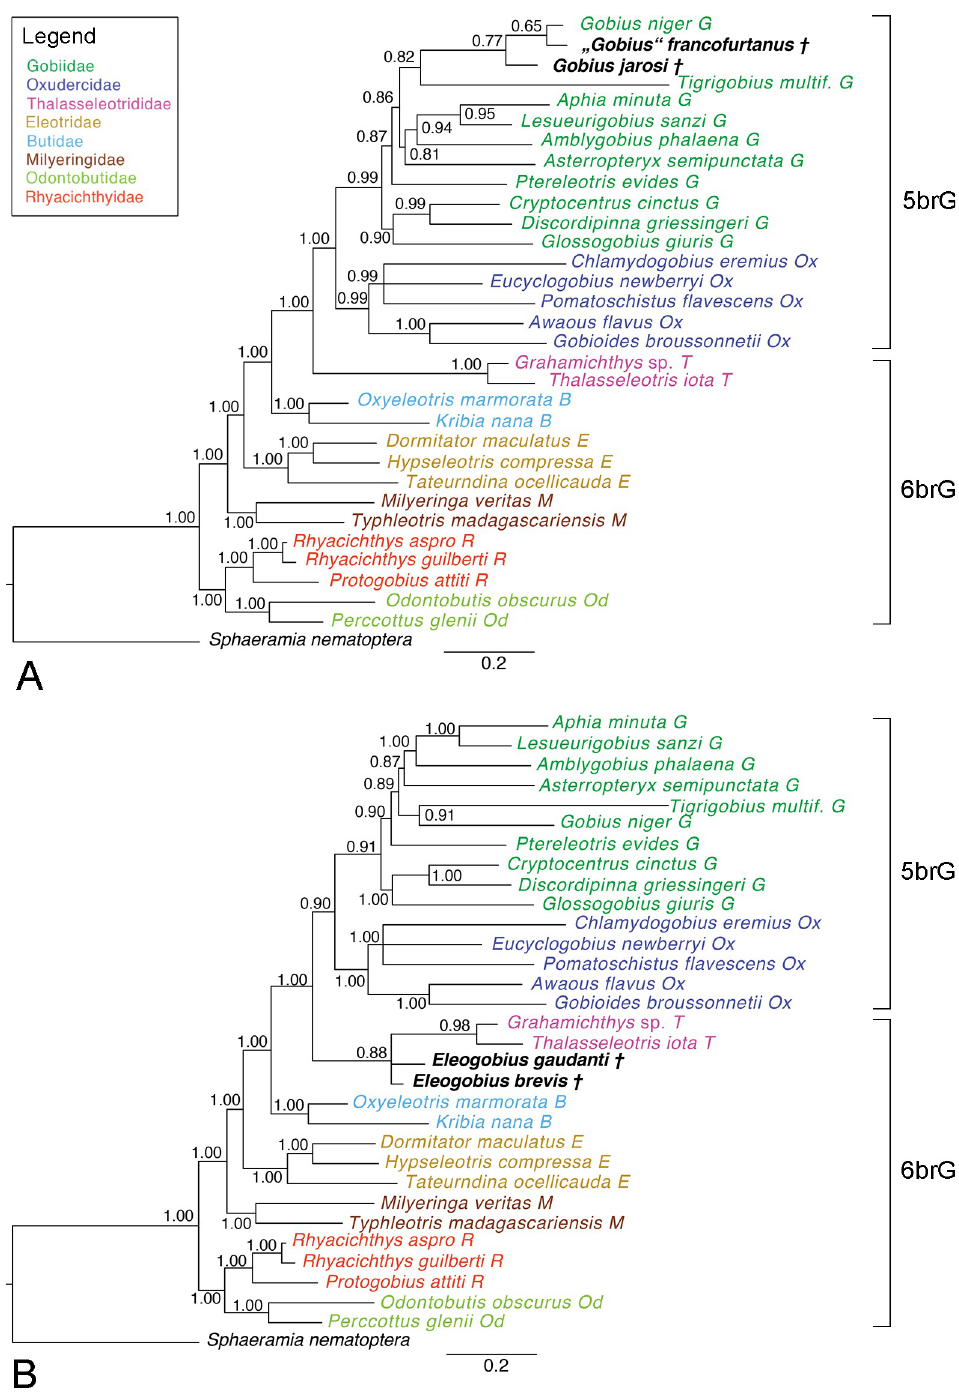
Fig 7. 50% MRC Bayesian trees with posterior probabilities based on the total-evidence dataset. A †“ Gobius ” francofurtanus and † G . jarosi were added to the extant species (ASDSF = 0.014107). B Both † Eleogobius species were added to the extant species (ASDSF = 0.004114). Scale bars, average number of substitutions per site respectively character changes per